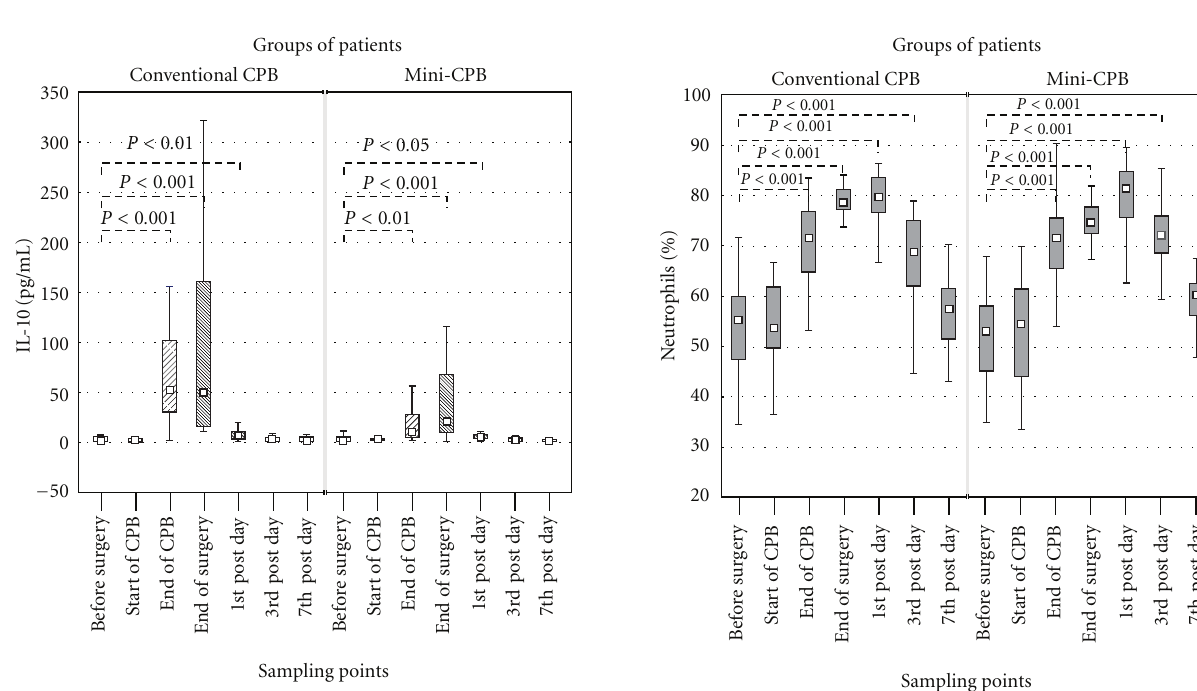
Figure 2: Percentage of neutrophils in peripheral blood samples of patients with conventional CPB or mini-CPB. The percentage of neutrophils was evaluated by flow cytometry. The percentage of neutrophils significantly di ff ered between both groups of patients at the end of surgery (79% of neutrophils in conventional CPB group versus 75% of neutrophils in mini-CPB group, P < 0 . 05). Squares display, median, boxes are quartiles, and whiskers display the range of nonoutlier